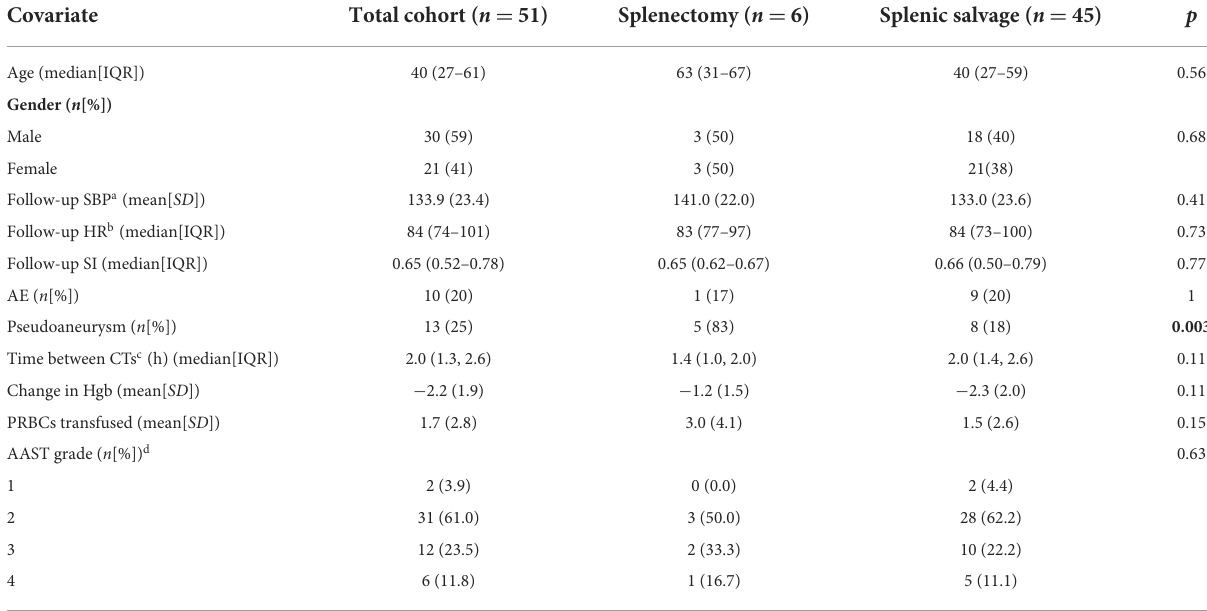
TABLE 1 Demographic and clinical characteristics.